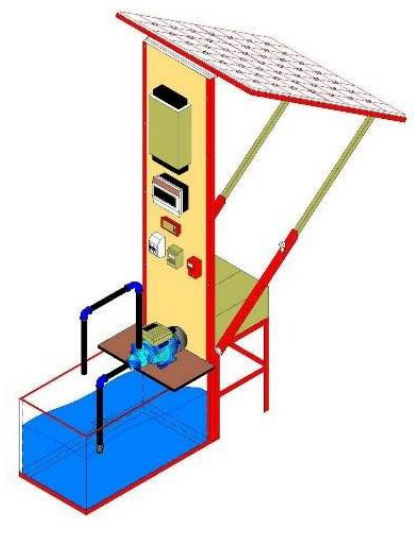
Figure 2: Design of Solar-Powered Water Pump